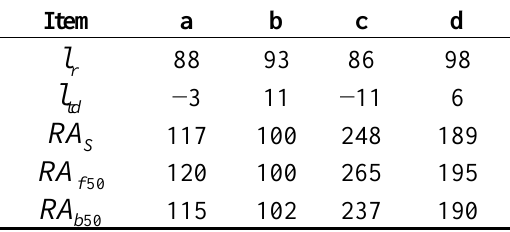
Table 5. The terrain drop measurement results corresponding to case-4.